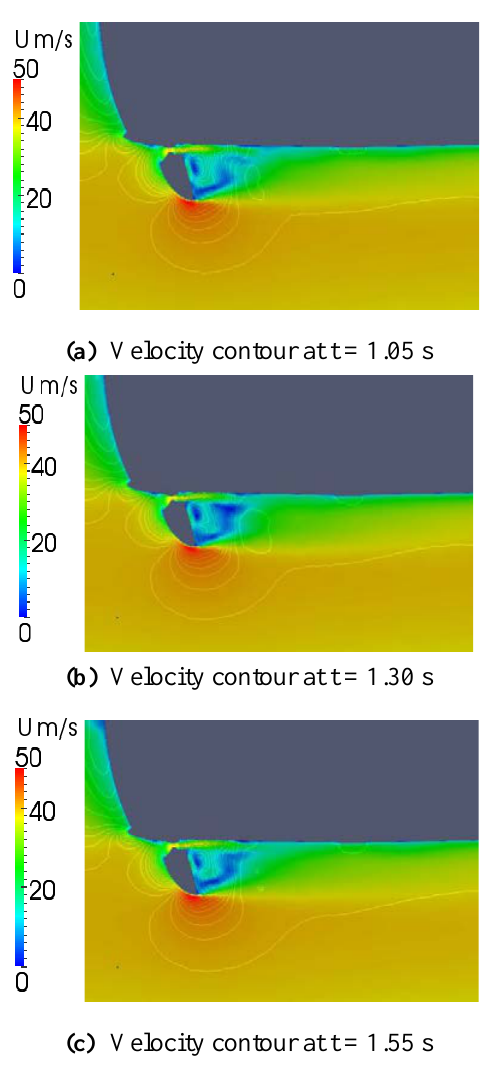
Figure 18. Velocity distribution in the cross-section obtained using DSLM at z = 1.12 m.